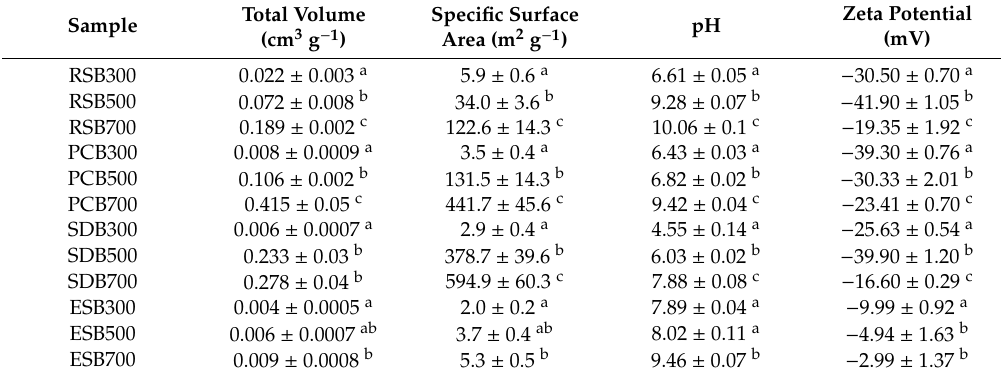
Table 1. Textural properties of di ff erent biochars.